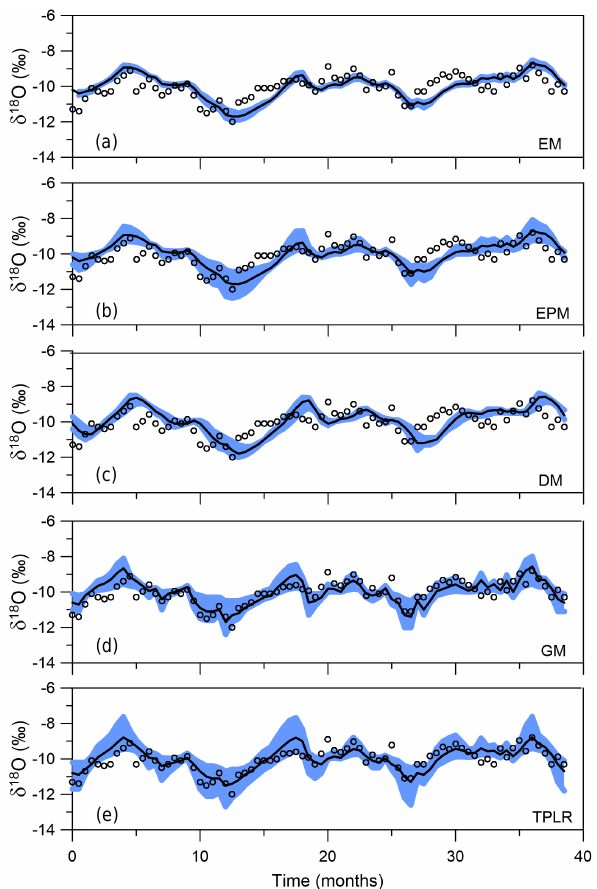
Figure 3. Fitted results of the five lumped parameter models used to simulate the temporal variability in the δ 18 O streamflow compo- sition at the outlet of the basin (M8). (a) Exponential model (EM); (b) exponential-piston model (EPM); (c) dispersion model (DM); (d) gamma model (GM); and (e) two parallel linear reservoir model (TPLR). The open circles represent the observed isotopic compo- sition in streamflow; the black line represents the best simulated isotopic composition in streamflow according to the KGE (Gupta et al., 2009) objective function; and the blue shaded area corresponds to the 5–95% confidence limits of the possible solutions from the parameter sets within the range of behavioral solutions, i.e., solu- tions that yield at least 95% KGE.